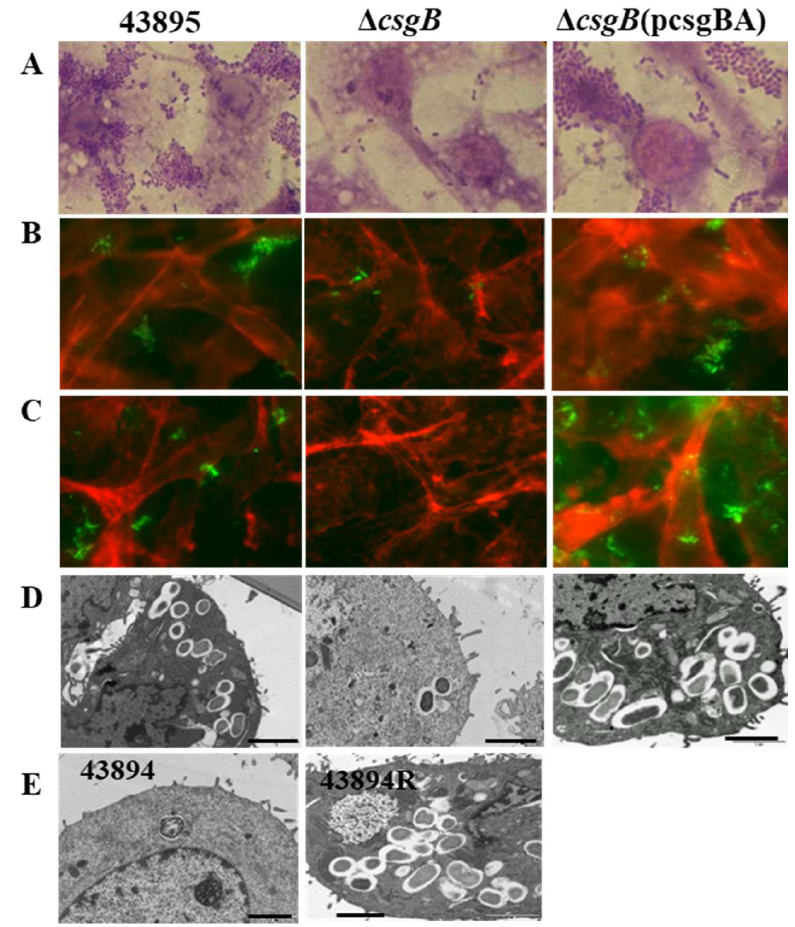
Figure 6. The role of curli in adherence to and invading MAC-T cells. Individual overnight cultures of E. coli O157:H7 43895, curli-negative Δ csgB , the complemented strain Δ csgB (pAB), and 43894R bacterial strains were co-cultured with MAC-T monolayers on coverslips at MOI = 10 and incubated for 3 hrs. Microscopy images show interaction of E. coli O157:H7 43895 and curli-negative mutant ∆ csgB , the complemented strain ∆ csgB (pAB), 43894 and 43894R with MAC-T monolayers. Curli-negative ∆ csgB, showed a ~10-fold reduction in adherence compared to wild type 43895 (data not shown and Table 3) ( A ) Giemsa stain showing the 43895 aggregative adherence pattern to MAC-T monolayers compared to binding of a ∆ csgB mutant (inverted microscope, magnification × 1000). ( B , C ) Immunofluorescence showing bacteria interact with MAC-Tcells (magnification × 1000) stained by ( B ) anti-O157 LPS antibody (green) or ( C ) anti-curli antibody (green), the host cell cytoskeleton was stained with phalloidin-TRITC (red). ( D , E ) TEM showing extracellular and intracellular bacteria (strains indicated at top left of each micrograph) adhered to or within the vacuoles of MAC-T cells (magnification, × 10,000). Ruler bars in D and E = 2 µm.